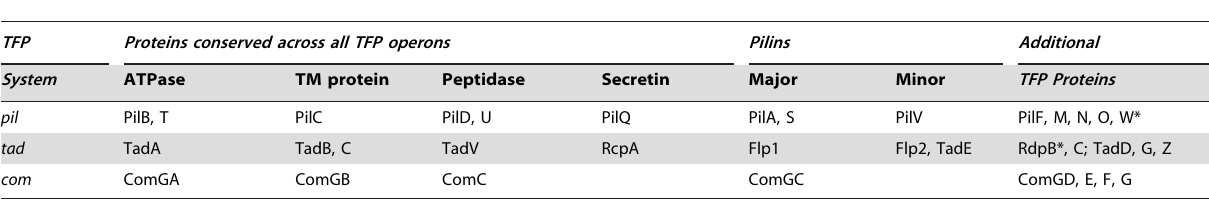
Table 1. Components encoded by TFP